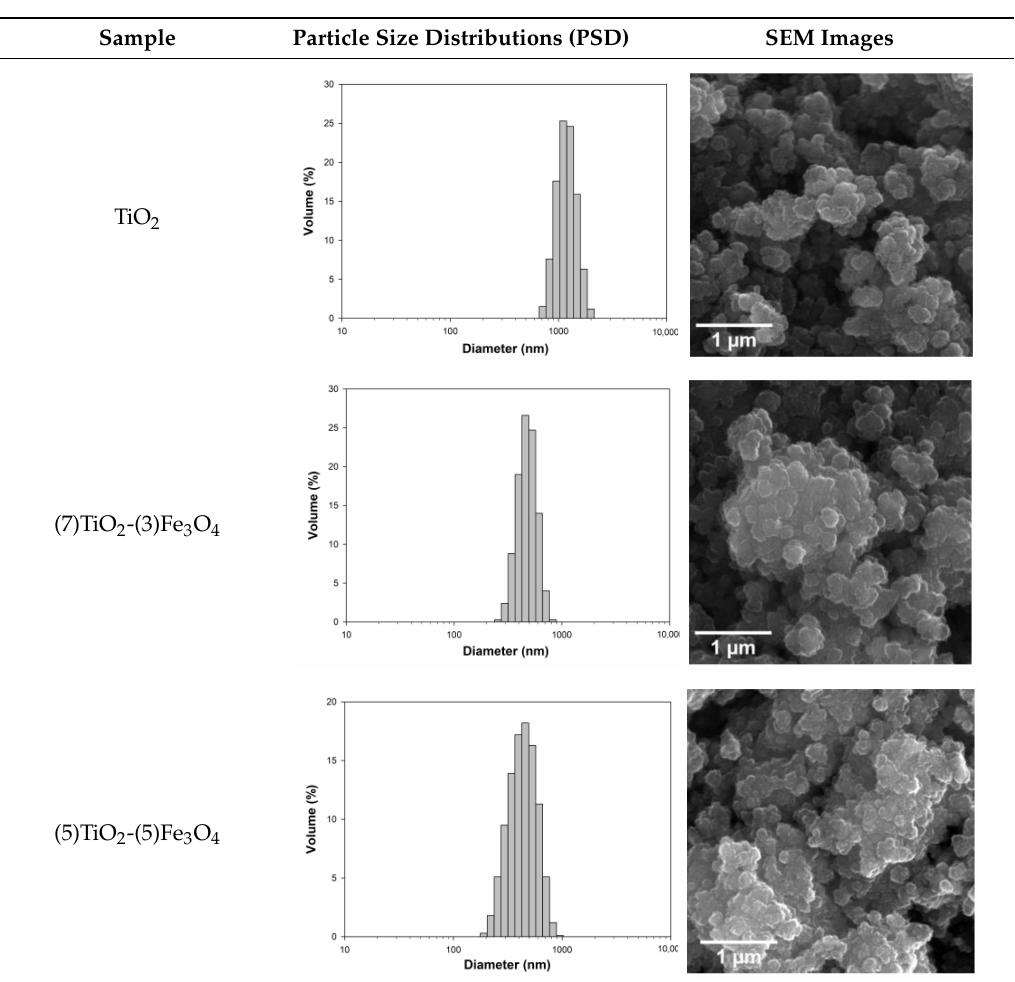
Table 1. PSDs and SEM images of the obtained composite and references